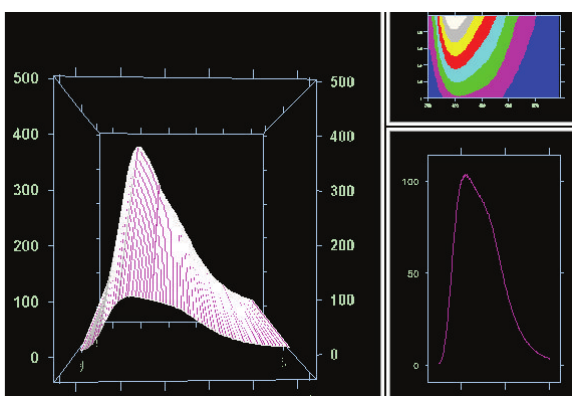
Figure 7: Emission spectra of pure resveratrol and resveratrol in presence of S7-OD on different temperatures (temperature increases from the observer to the image